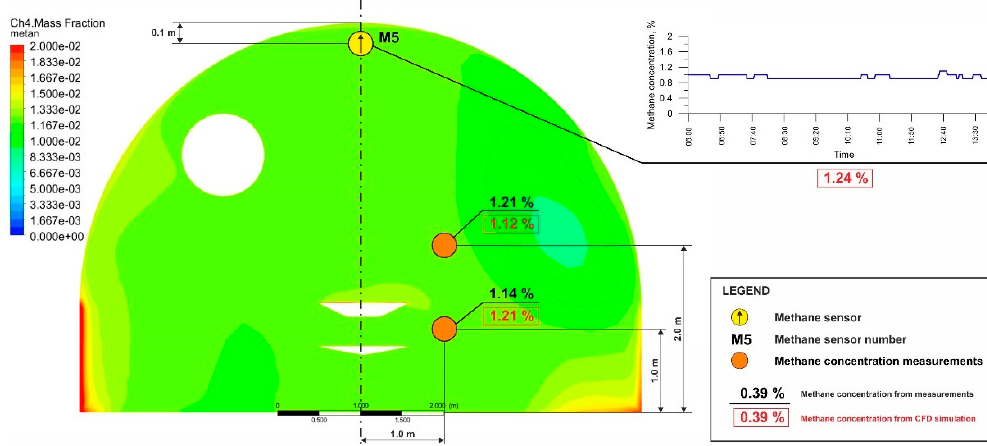
Figure 7. Distribution of methane concentration in the section of the roadway at a distance of 42 m from face with the location of the M5 methane sensor (10 m from the end of the overlap zone). location of the M5 methane sensor (10 m from the end of the overlap